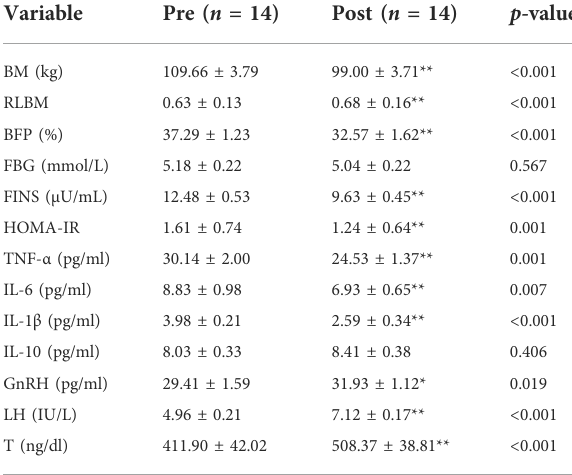
TABLE 2 Differences of obesity-related indexes before and after exercise diet